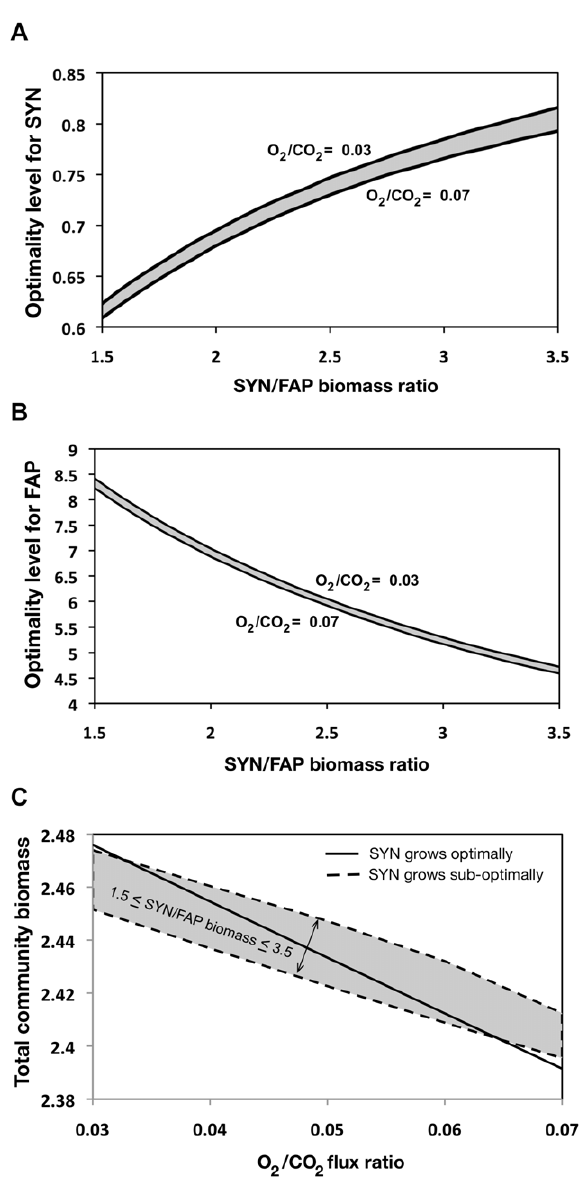
Figure 4. Optimality levels for the SYN and FAP guilds and their effect on the total community biomass. Optimality levels for (A) SYN and (B) FAP as a function of the SYN/FAP biomass ratio across different values of the O 2 /CO 2 flux ratio (C) Comparison of the predicted total community biomass (1/h) for the case when SYN grows sub- optimally and when it grows optimally. Note that, to compute the total community biomass when SYN grows optimally only O 2 /CO 2 flux ratio was fixed at values in the experimentally determined range (i.e., 0.03 to 0.07), whereas for all other cases, in addition to O 2 /CO 2 flux ratio, SYN/ FAP biomass ratio was also fixed at values measured experimentally (i.e., 1.5 to 3.5). Lower and upper dashed lines in (C) represent the maximum and minimum predicted community biomass (when SYN grows sub-optimally) across various SYN/FAP biomass ratios.